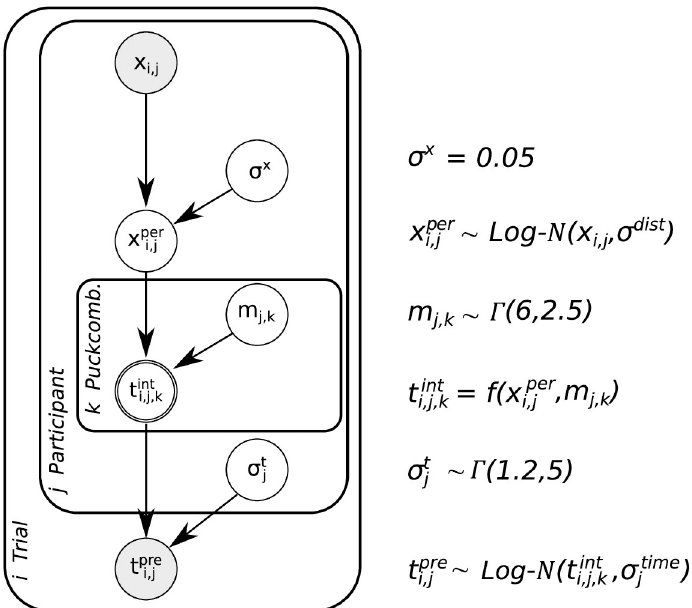
Fig 4. Hierarchical Bayesian network for the Newtonian interaction model. The model expresses the generative process of observed press-times t pre across trials i , participants j , and pucks k including Weber-Fechner scaling given i ; j perceptual uncertainties of distance x and mass m of the pucks and subjects’ press-time variability. The parameter i , j j , k values refer to the prior probability distributions. See the text for details.